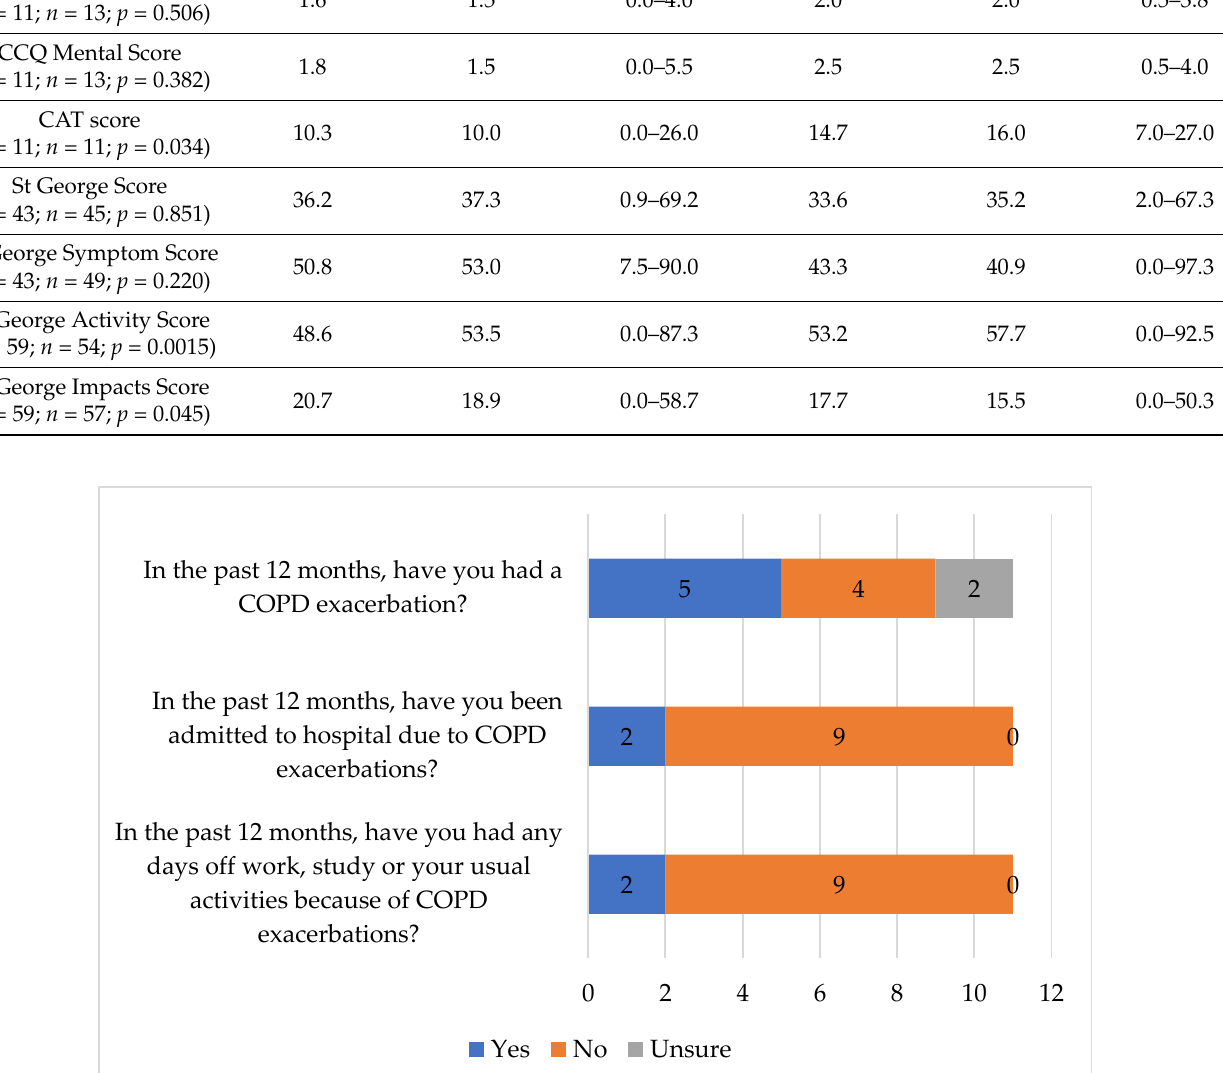
Figure 3. Respondents’ agreement with statements related to COPD.